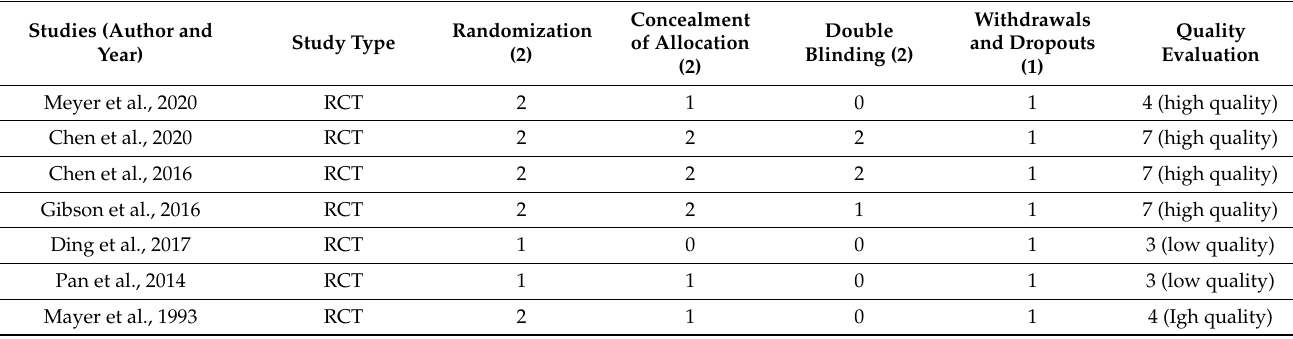
Table 3. Quality evaluation of randomized controlled clinical